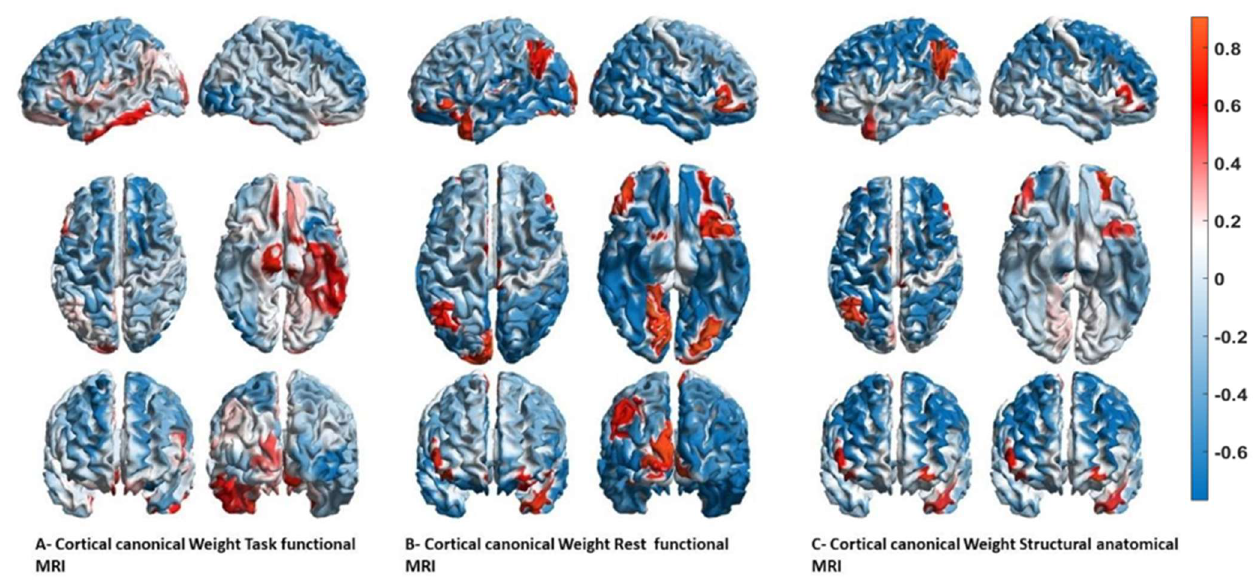
Figure 3. Canonical weighting for the three modalities in explaining different diagnostics. These figures represent the projection of the mass multivariate MLM weights onto a 3D cortical mesh for each modality. ( A ) Task fMRI, ( B ) rest fMRI, and ( C ) anatomical structural MRI. The top row shows the left and right views, the middle row shows the top view, and the bottom row shows the front and rear views. Blue represents a negative contribution, and red represents a positive contribution (please note that the signs are arbitrary, as with any multivariate